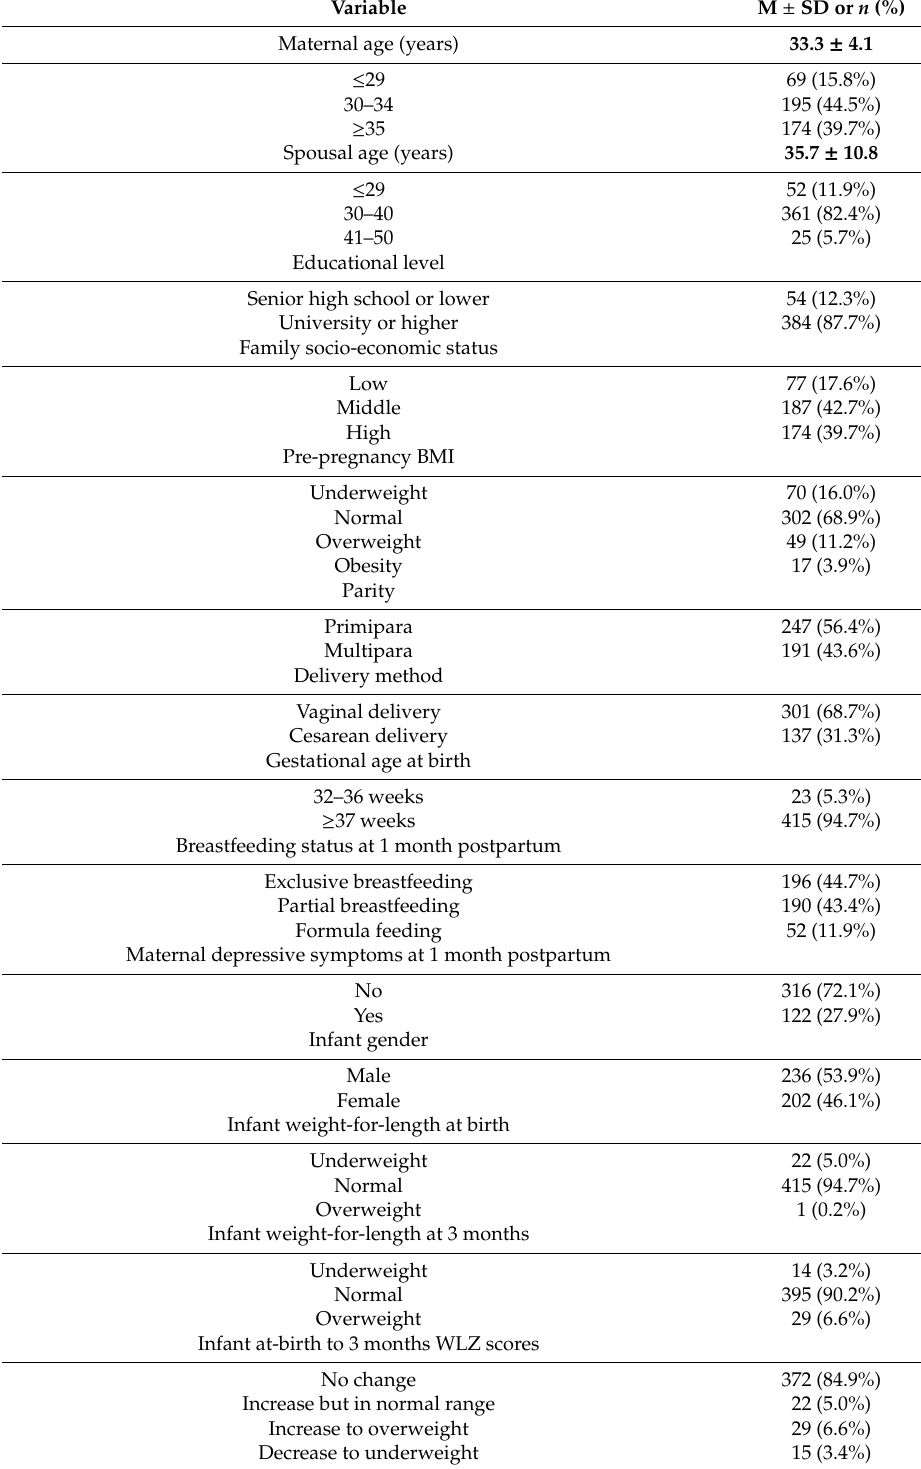
Table 3. Participant characteristics ( n =